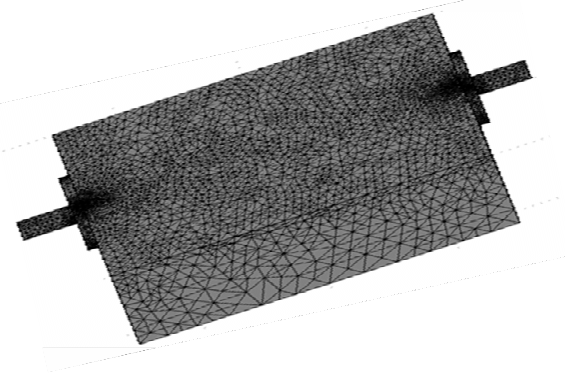
Figure 3. Mesh of microstrip for finite element method (FEM) simulation.